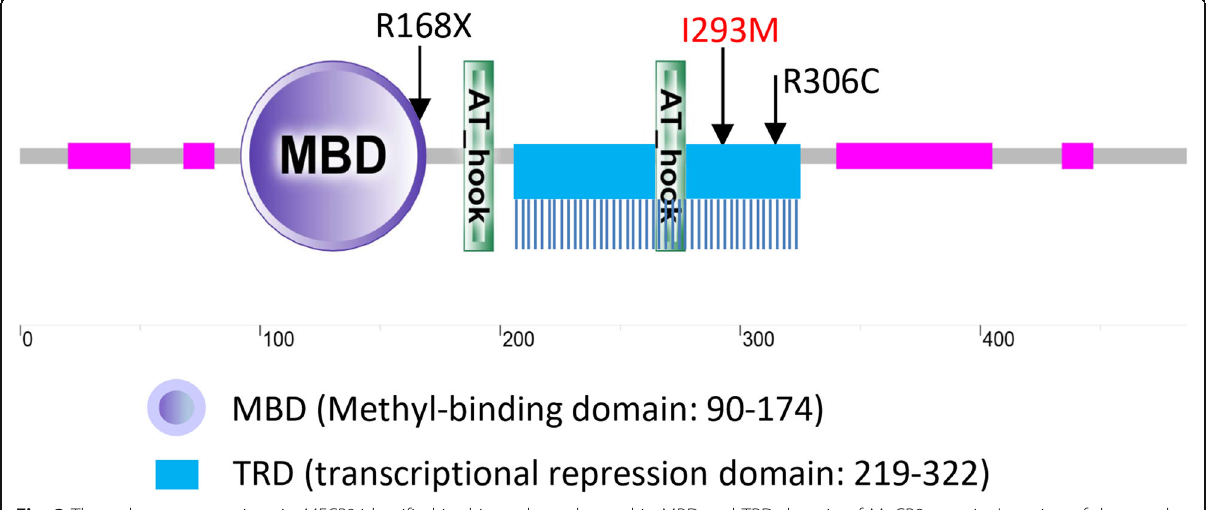
Fig. 3 Three de novo mutations in MECP2 identified in this study are located in MBD and TRD domain of MeCP2 protein. Location of the novel DNM p.(Ile293Met) (I293M) in TRD domain is labeled in red. Multiple vertical lines beneath the blue box represent 62 different mutations in TRD domain (HGMD), which appears to be evenly distributed within the domain composed of 104 amino acids. Both p.(Arg168*) (R168X) and p.(Arg306Cys) (R306C) mutations in the first two patients are hot alleles. MeCP2 domains are predicted by SMART analysis (http://smart.embl- heidelberg.de/). AT-hook is a DNA-binding motif. Pink boxes represent low compositional complexity